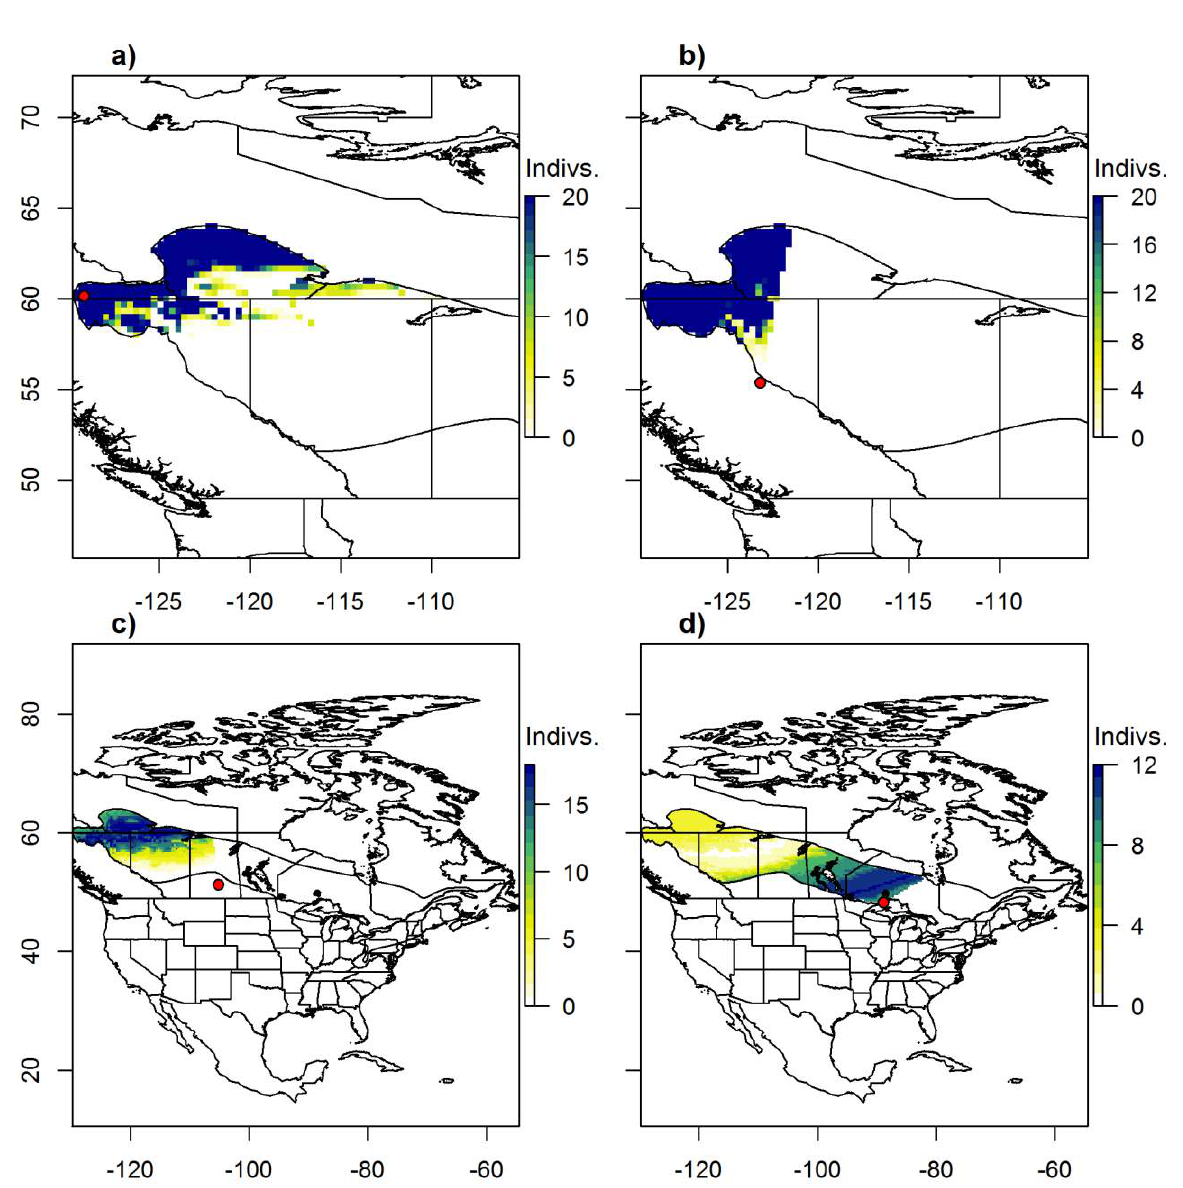
Figure A2.15: Probable origins of Magnolia Warblers ( Setophaga magnolia ) captured during fall migration at CMMN stations in a) the Yukon (ACBO (n=20)); b) Northern British Columbia (MNO (n=20)); c) Saskatchewan (LMBO (n=19)); d) Western Ontario (TCBO (n=19)); e) Southwest Ontario (BPBO (n=3), HBO (n=5), LPBO (n=3), PIBO (n=3), TTPBRS (n=5)); f) Southeast Ontario & Southwest Québec (MBO (n=4), PEPTBO (n=12)); and h) Eastern Canada (ABO (n=13), SABBS